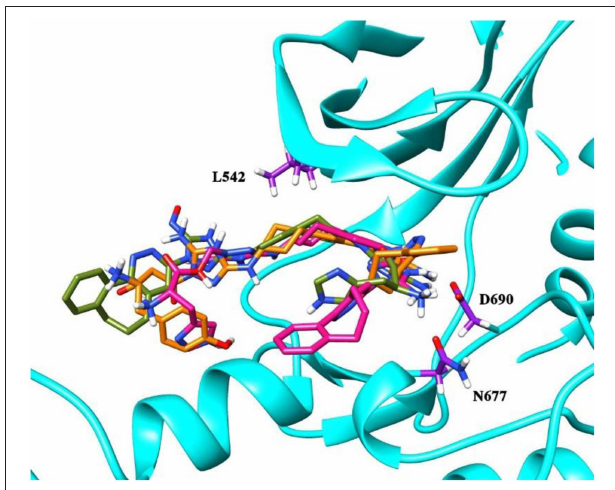
FIGURE 5 | The superposition of the three top-scoring compounds designed. The compound R3 is shown in deep pink , the compound R5 is shown in orange , and the compound R10 is shown in olive green . The backbone of the kinase is represented as a secondary structure and highlighted in cyan; some of the key residues in the binding pocket—D690, N677, and L542—are shown as licorice and indicated in purple . TABLE 6 | The list of cavity residues involved in the H-bond formations as well as in the short-range van der Waals interactions with the designed compounds R1–R10 according to the GOLD software. Compound